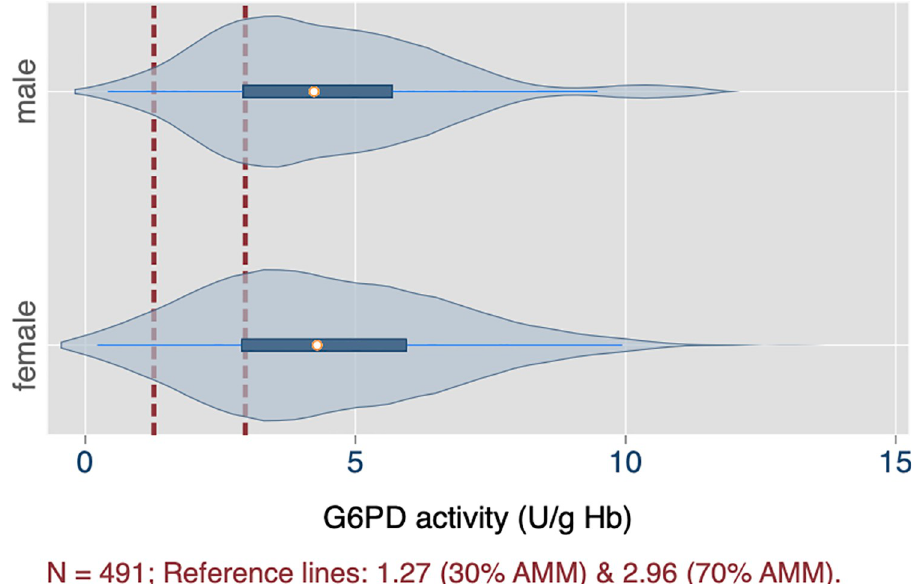
Fig 3. Distribution of G6PD activities in study population, by study site (n =